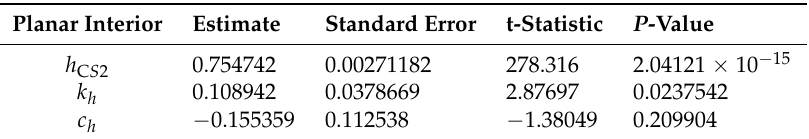
Table 5. The parameters of fitting h S 2 = h C S 2 + k h of the vortex interior. h CS 2 inside the vortex is clearly higher, than on the vortex edge, outside or in the whole vacuum (compare to Table